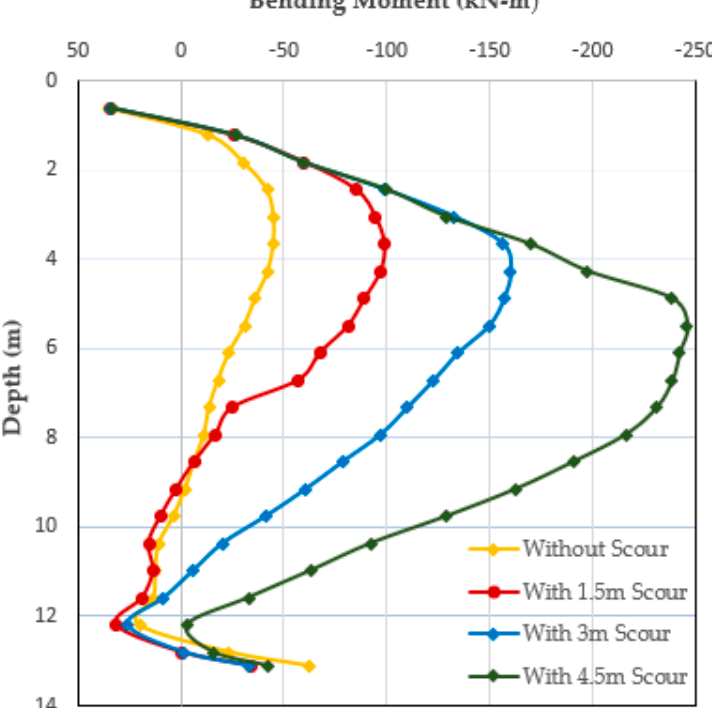
Figure 12. Bending moment profiles for no scour and scour cases 1–3. Table 6. Bending moment (kN-m) for different scour scenarios. Scour Depth(m) Max. Bending Moment (kN-m) No Scour